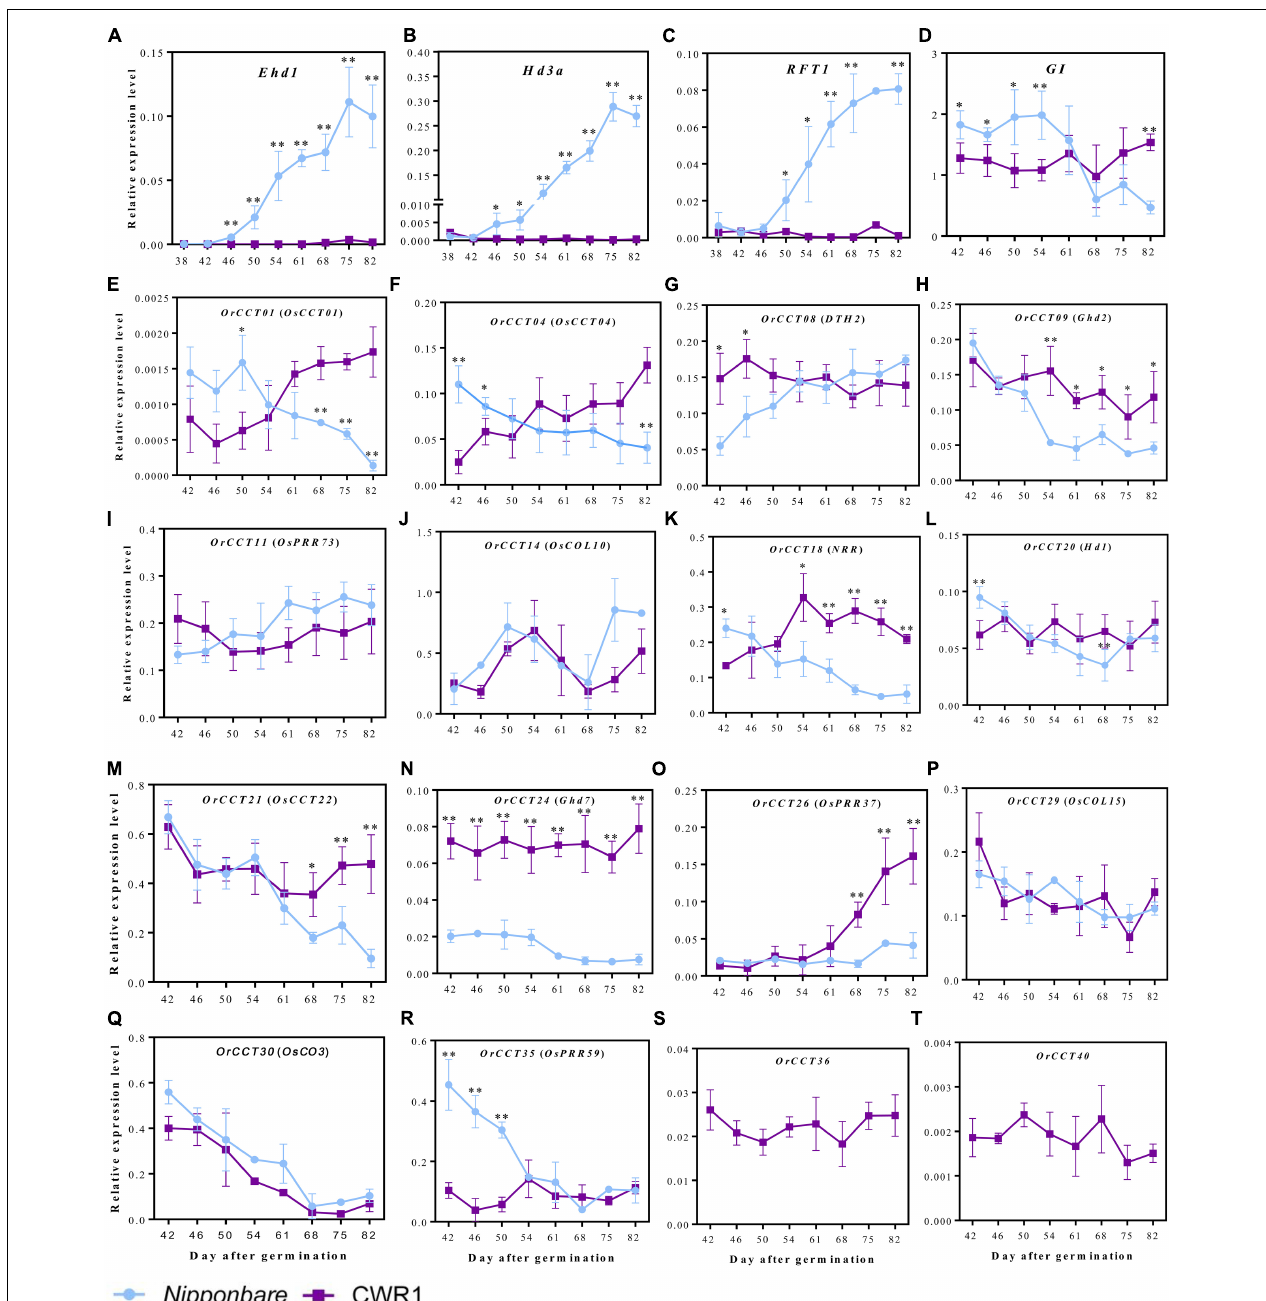
FIGURE 5 | The transcript levels of Ehd1 (A) , Hd3a (B) , RFT1 (C) , OsGI (D) , and 16 CCT genes (E–T) in leaf blades of Nipponbare and O. rufipogon (CWR1) at different developmental stages. Leaf blade samples were isolated at ZT-2 h, ZT-8 h, and ZT-15 h at 4 days intervals starting from 38 DAG. Transcript levels are relative to OsUbi1 . Error bars indicate standard deviation for five biological replicates. ∗ , ∗∗ significant differences by Student’s t -test at P ≤ 0.05 and P ≤ 0.01,